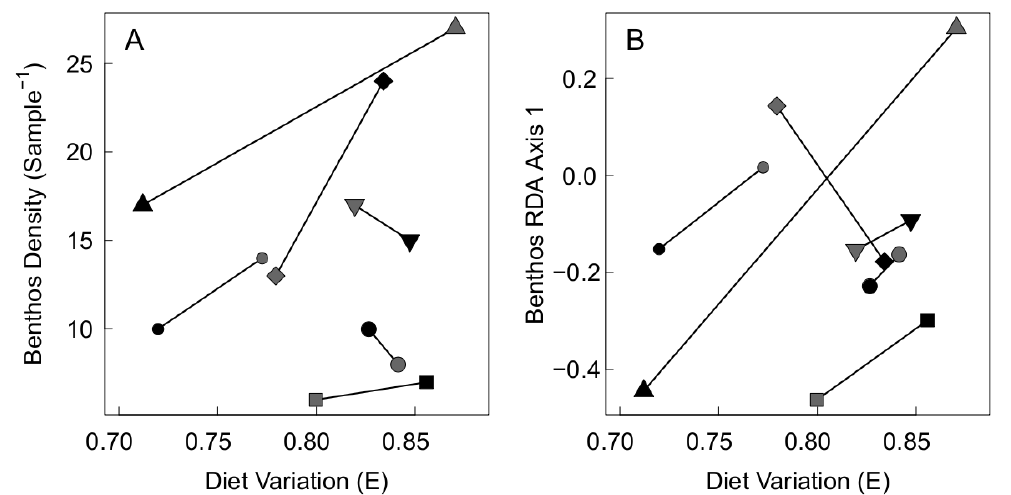
Figure 5. Post-hoc analysis of relationships between diet variation and the prey community in the enclosures. Mean pairwise diet dissimilarity (E) is compared to a) benthic invertebrate density and b) benthic invertebrate composition, measured as the first RDA axis. Symbols correspond to spatial blocks; black symbols indicate high size variance treatment, while grey symbols indicate low size variance.